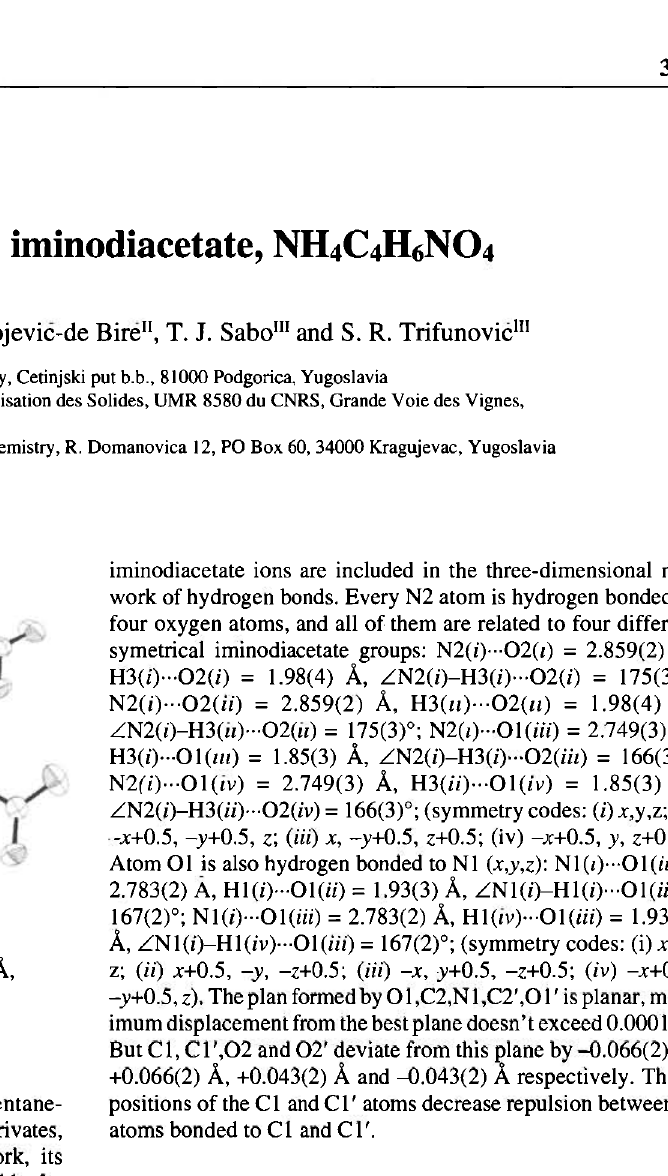
Table 1. Data collection and handling.